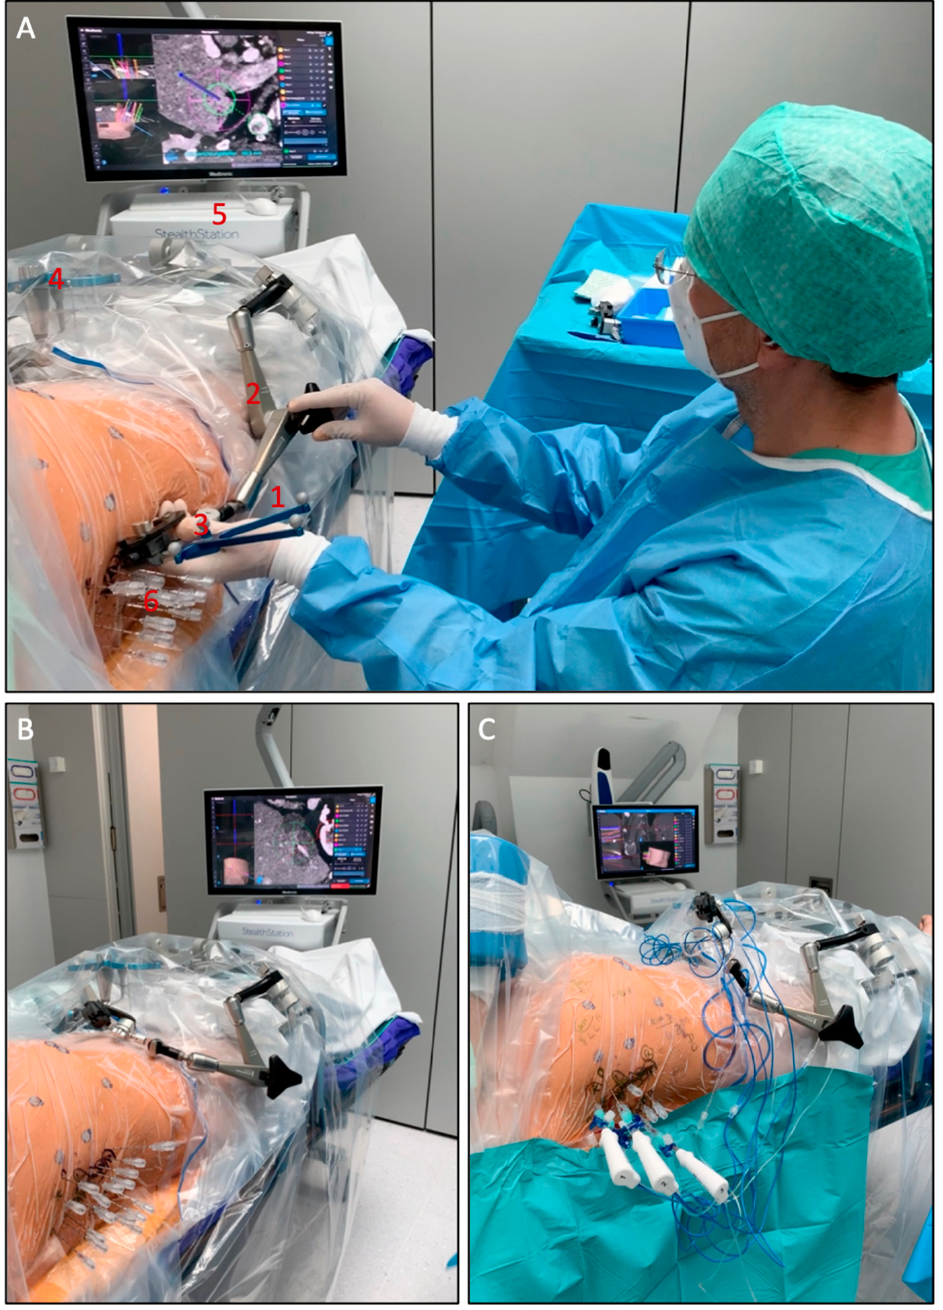
Figure 1. Setup of the SRFA procedure. ( A ) The probe (1) of the navigation system is inserted into the ATLAS aiming device (2). The reflective markers (3) on the probe and the reference frame (4) are tracked by the camera of the navigation system (5). After manual alignment of the aiming device with the virtual trajectory and consecutive removal of the probe, the interventionalist introduces several coaxial needles (6) through the locked aiming device to the preplanned target point. ( B ) Placed coaxial needles in final position. ( C ) After verification of correct needle placement with a non-enhanced control CT scan and image fusion with the planning-CT up to three RF-electrodes at a time are introduced through the coaxial needles for serial tumor ablation.